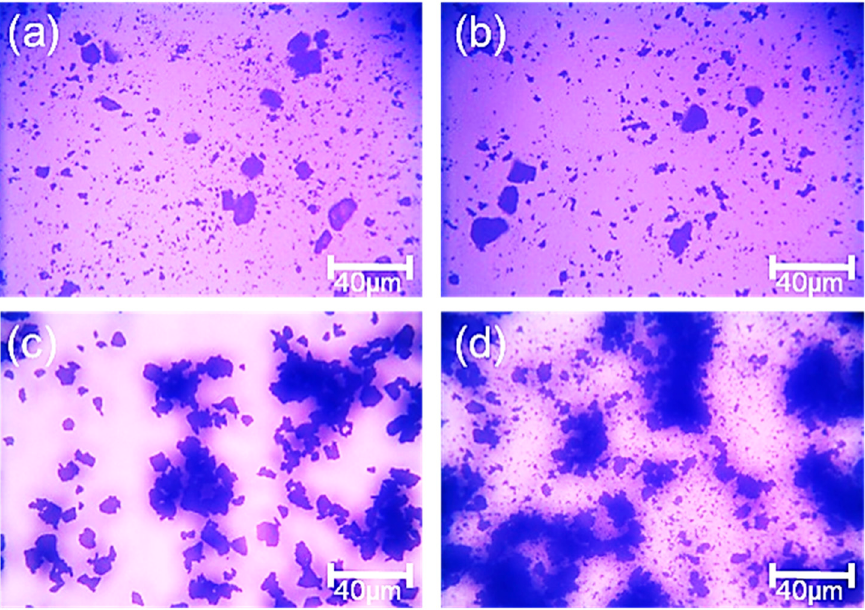
Figure 7. Distribution of fine pyrite under an optical microscope. ( a ) Pyrite + distilled water; ( b ) pyrite + copper sulfate; ( c ) pyrite + terpineol; ( d ) pyrite + butyl xanthate.